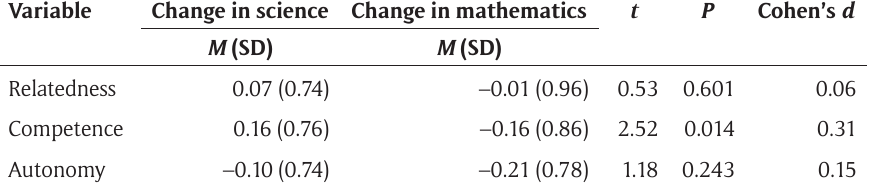
Table 2: Comparison of changes in participants’ perceptions of three psychological needs between science and math- ematics measures.